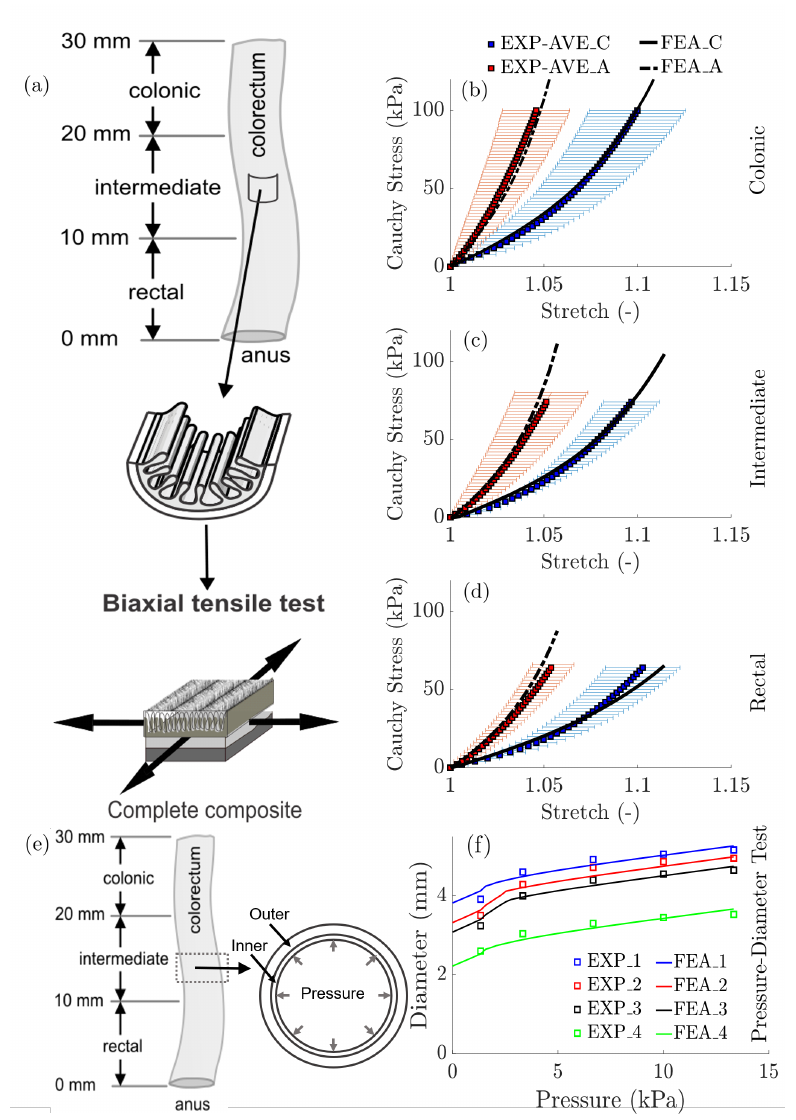
Figure 2. Simulation results: ( a ) Schematic diagram of the biaxial extension tests performed on three locations of bulk composite colorectum. ( b – d ) Mean experimental data (red and blue squares, plus error bars for standard deviation) with corresponding model predictions (solid and dashed curves) for ( b ) colonic, ( c ) intermediate, and ( d ) rectal bulk composite specimens of colorectum undergoing biaxial extensions. EXP = EXPeriment, AVE = Mean, FEA = Finite Element Analyses, C = Circumferential, and A = Axial. ( e ) Schematic diagram of the pressure-diameter tests performed on the tubular specimens of the coloretum. ( f ) Comparison of FE analyses with experimental measurements of diameter changes vs. increased pressure (adapted from